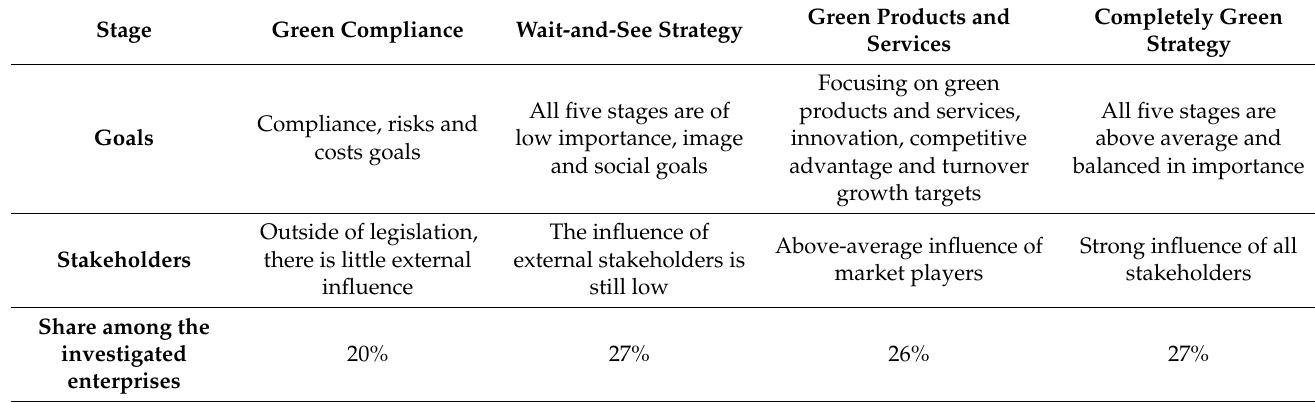
Table 3. Isensee and Michel’s (2011) green strategies. Source: based on Isensee and Michel (2011) and Michel et al. (2014). Edited by